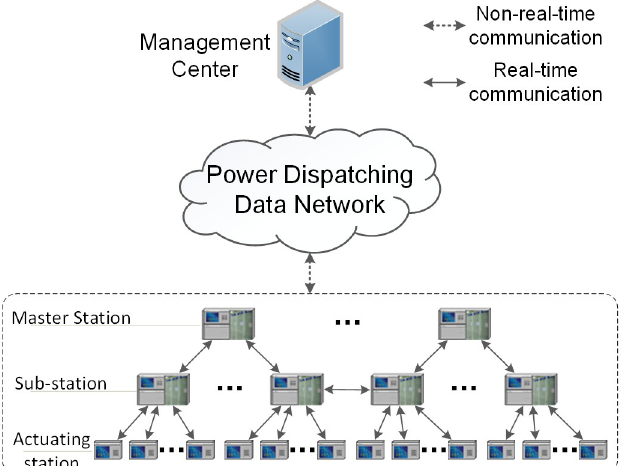
Fig 1. Layered architecture of